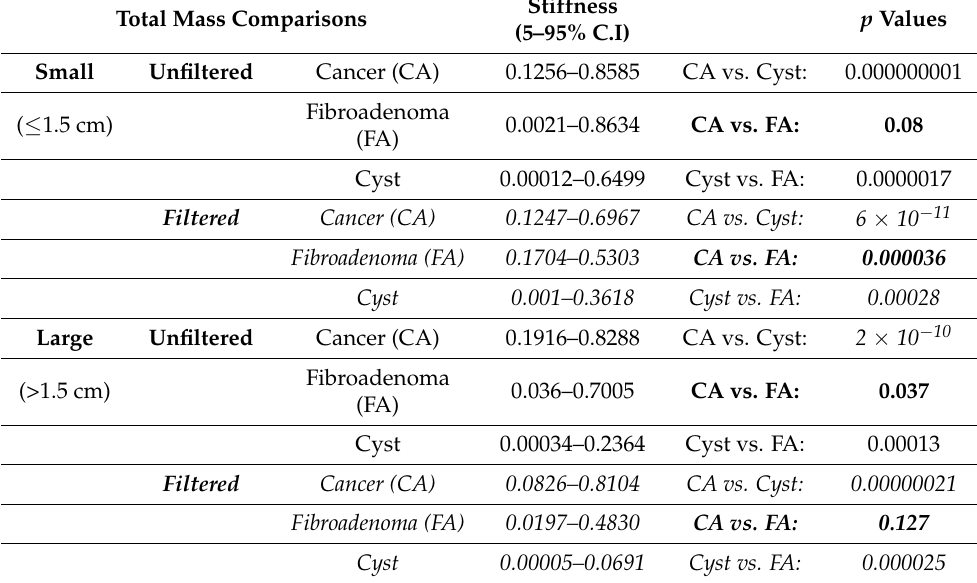
Table 4. Mass comparisons according to size and stiffness values using unfiltered and filtered stiffness values (also italicized). The spatially filtered algorithm accentuated smaller masses, producing significantly better differentiation of cancers from fibroadenomas (bolded). Conversely, spatial filtering degraded performance for larger, solid mass differentiation